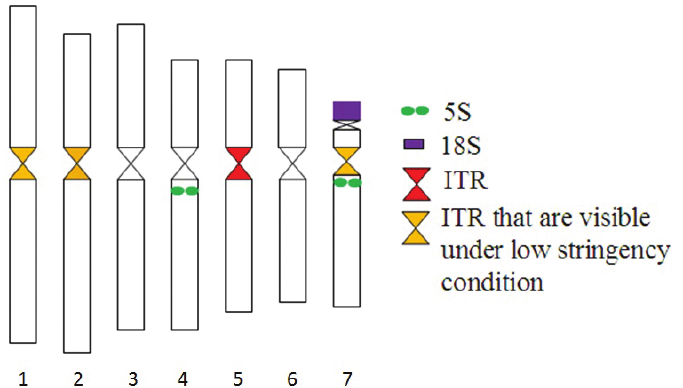
Figure 3. Distribution of the repetitive sequences on the mitotic R. wichurana chromosomes. 1 – ITR1: signals that are visible under hybridization at 37°C as well as at low temperature (23–25°C). 2 – ITR2: signals that are visible only under hybridization at low temperature (23–25°C).